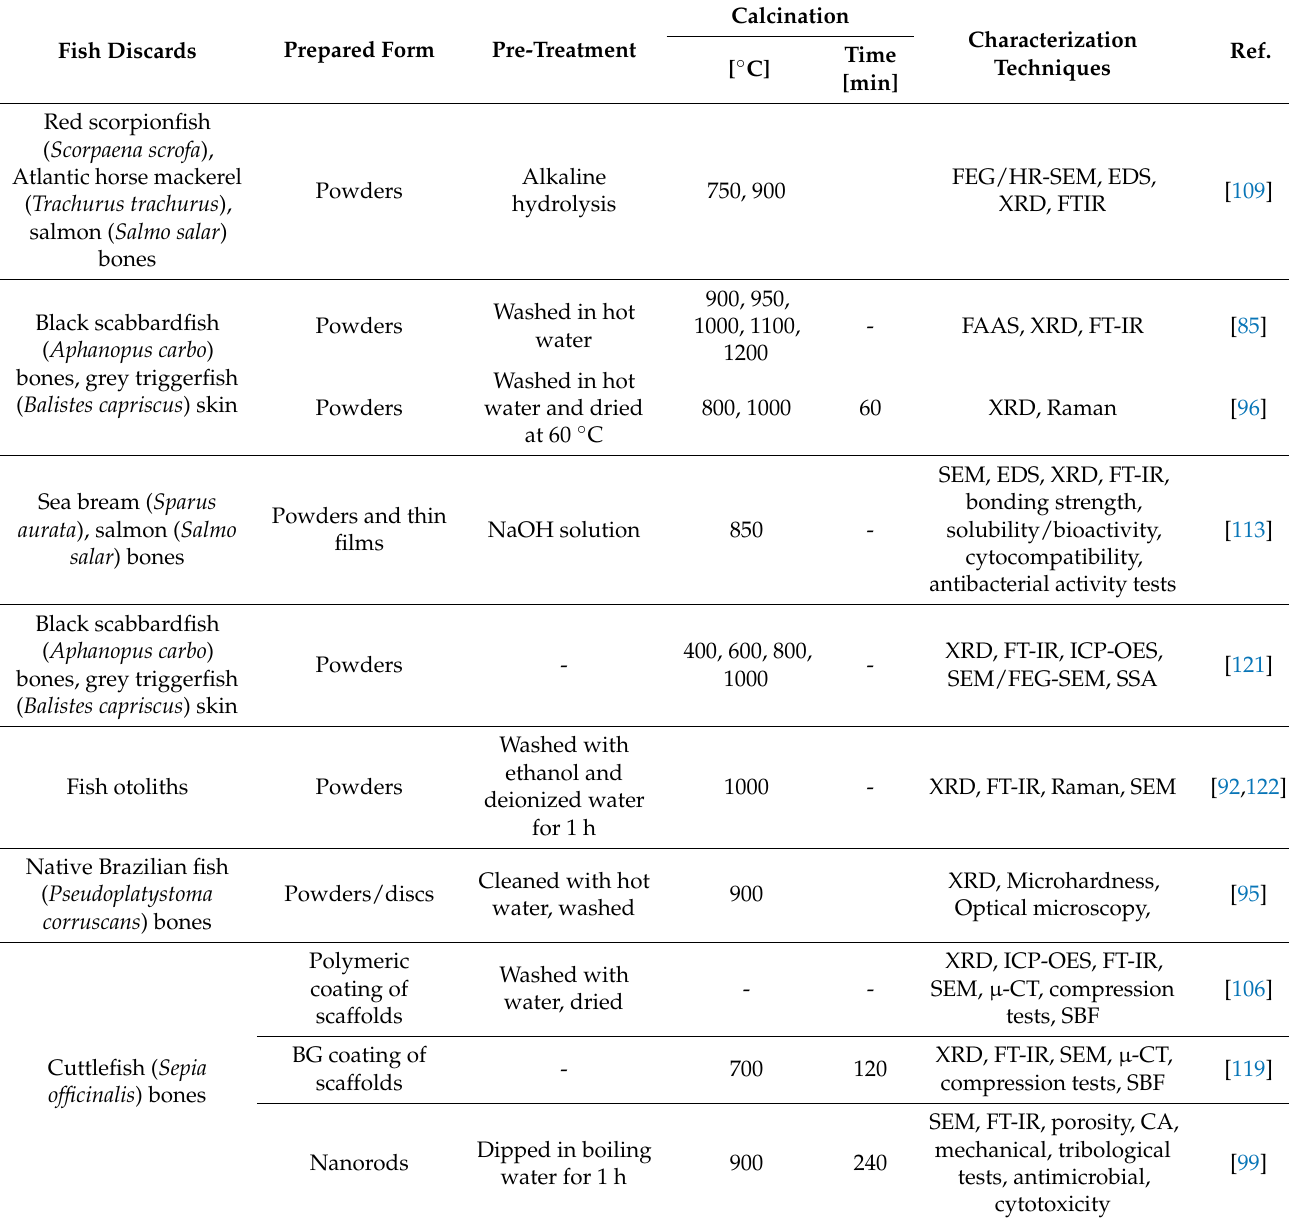
Table 1. Preparation of BCP materials derived from various fish